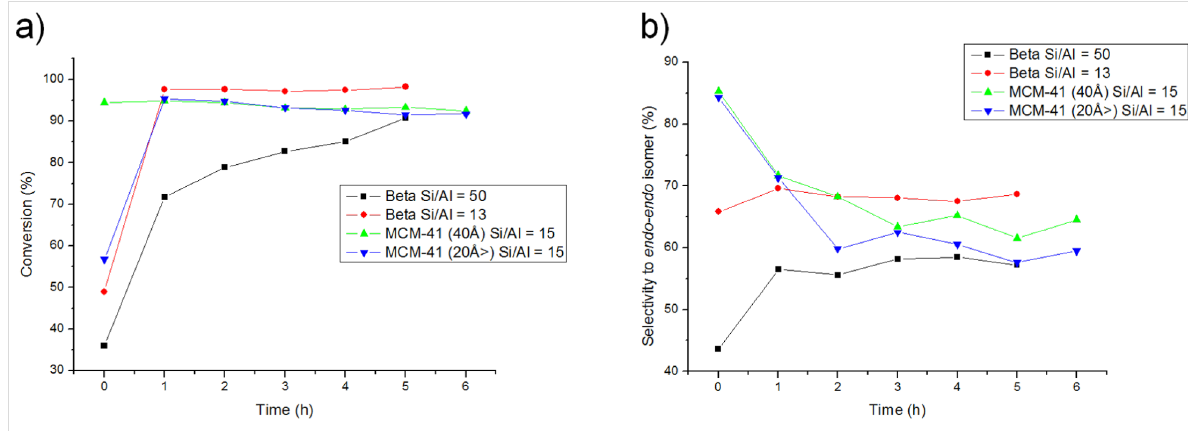
Figure 4: Comparison of conversion (a) and selectivity (b) of the DAR catalysed by Al-Beta zeolite and MCM-41.